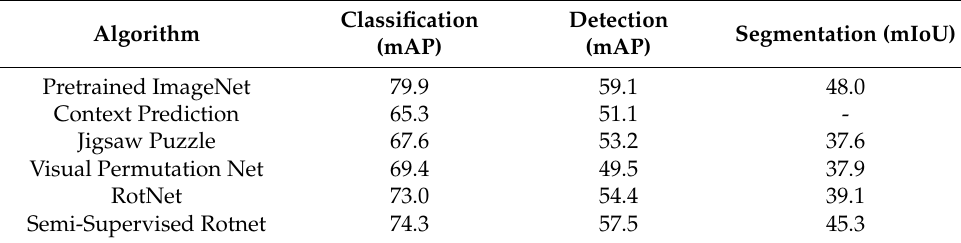
Table 1. Results of transferring learned feature representations from Pixel-to-Scalar pretext tasks for the downstream tasks of classification and detection on the PASCAL VOC 2007 dataset and segmentation on the PASCAL VOC 2012 dataset using a standard AlexNet architecture. Evaluation Metrics are included in parenthesis: mean average precision (mAP) and mean intersection over union